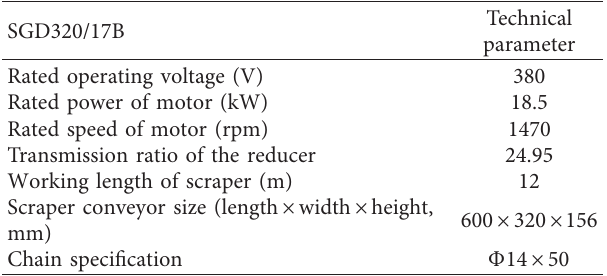
Table 1: Technical parameters of the test